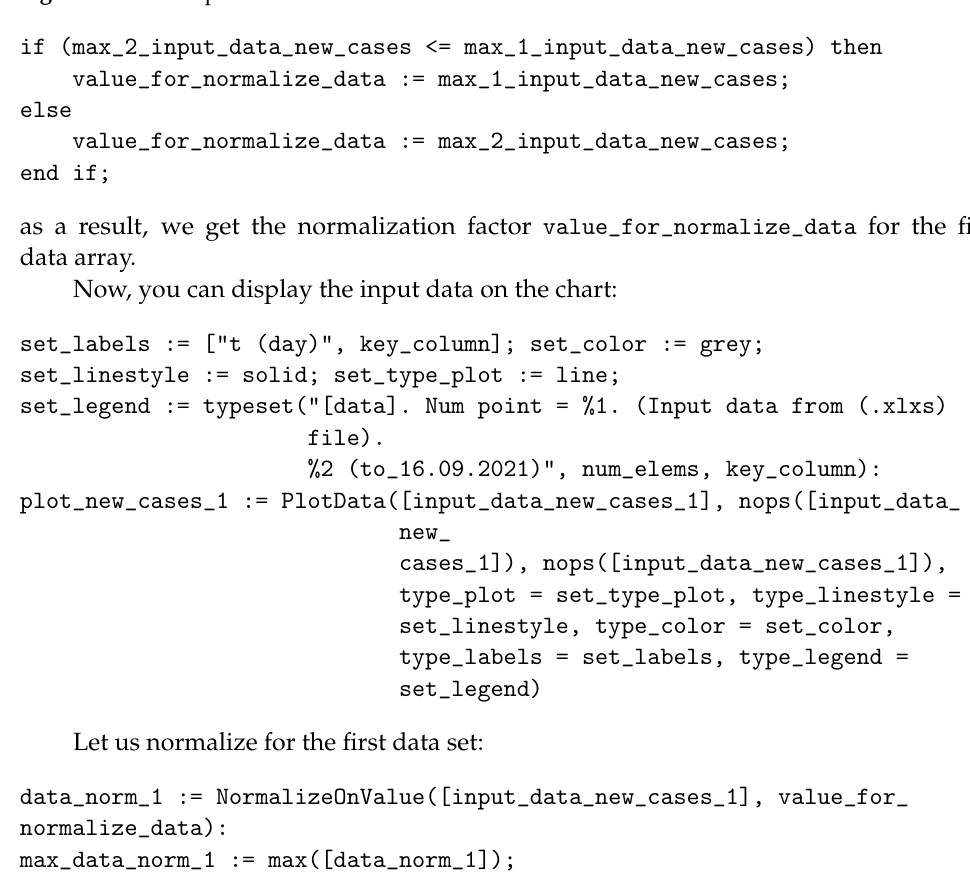
Figure 3. An example of a case of incorrect normalization of two data